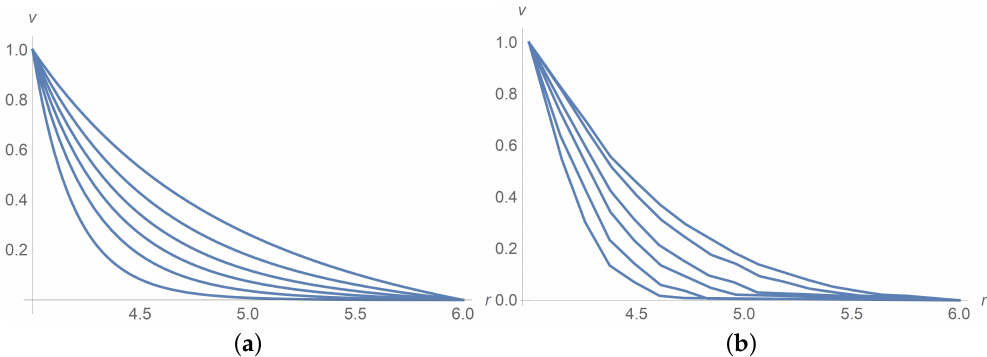
Figure 2. Dimensionless velocity profiles versus the radial variable in pure interstitial Herschel– Bulkley fluid without particles, φ = 0, for Ω = 2,5,10,20,50,100 [ rpm ] from the bottom upwards. ( a ) calculations, ( b ) measured data [9]